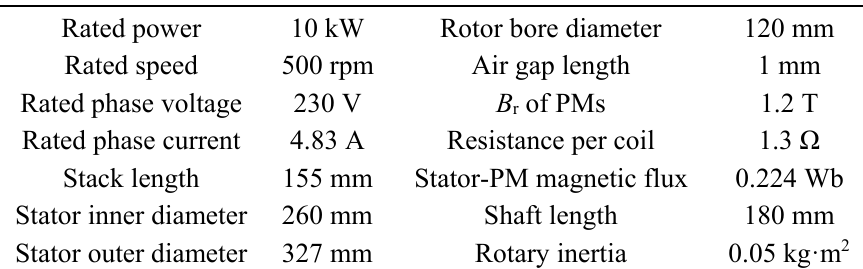
Figure 1. 36/34-pole NP-FSPM machine. ( a ) Cross section; ( b ) Prototype of stator and rotor. Nonlinear transient finite-element (FE) analysis is utilized to calculate the back electromotive force (EMF) and the cogging torque of the machine. Table 1. Key design parameters of the nine-phase flux-switching permanent-magnet (NP-FSPM)